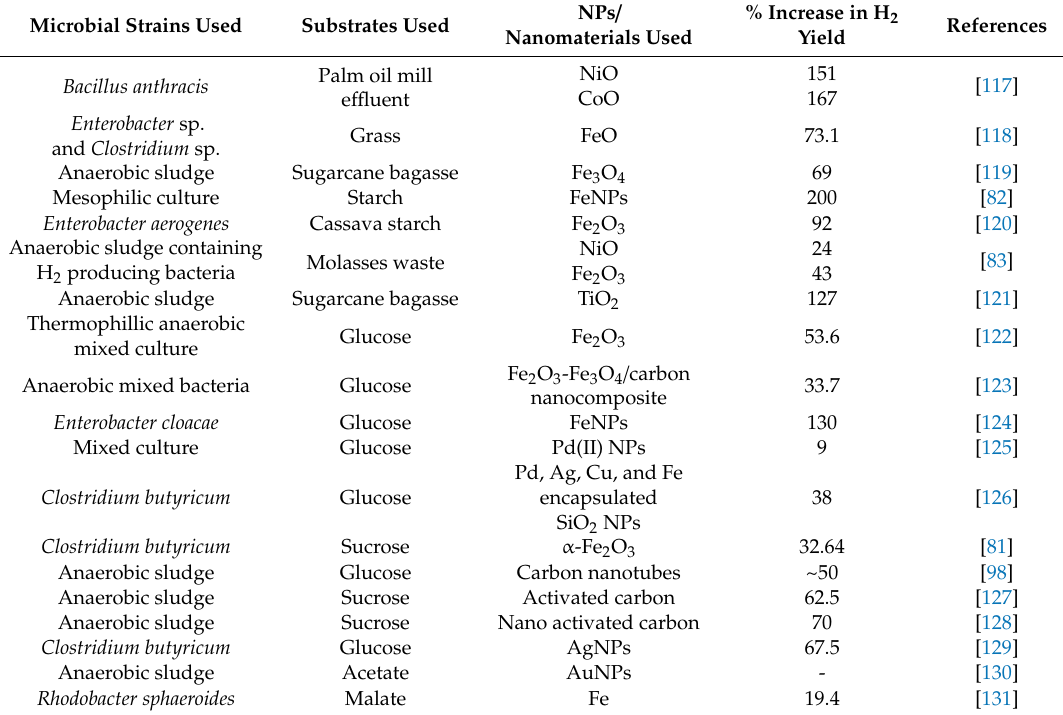
Table 3. Biohydrogen production from di ff erent substrates using various nanoparticles / nanomaterials. Microbial Strains